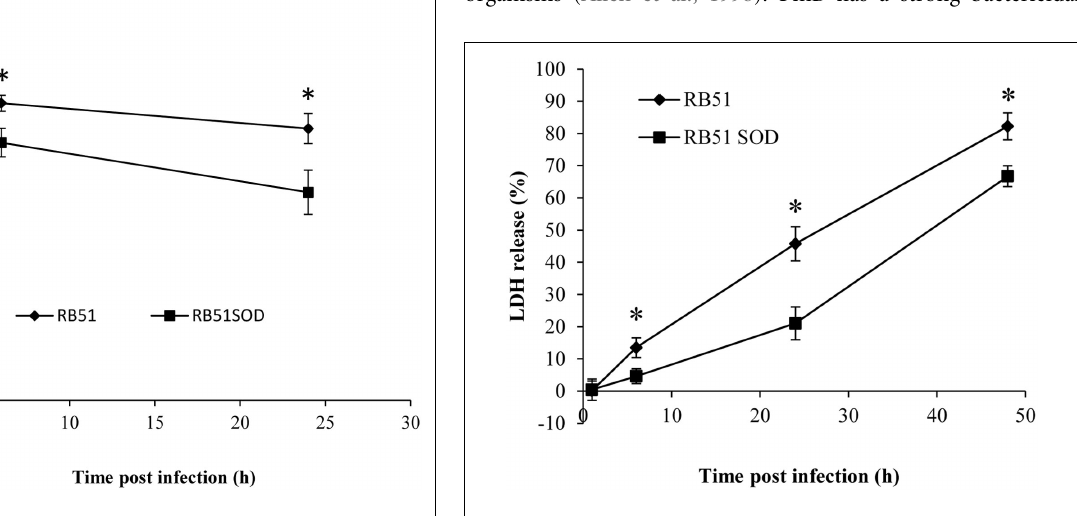
FIGURE 2 | Growth kinetics of RB51 and RB51SOD inside macrophages. The data represent the means ± SD from three independent experiments with an MOI of 200.The sign ∗ represents statistical significance ( P -value < 0.05).